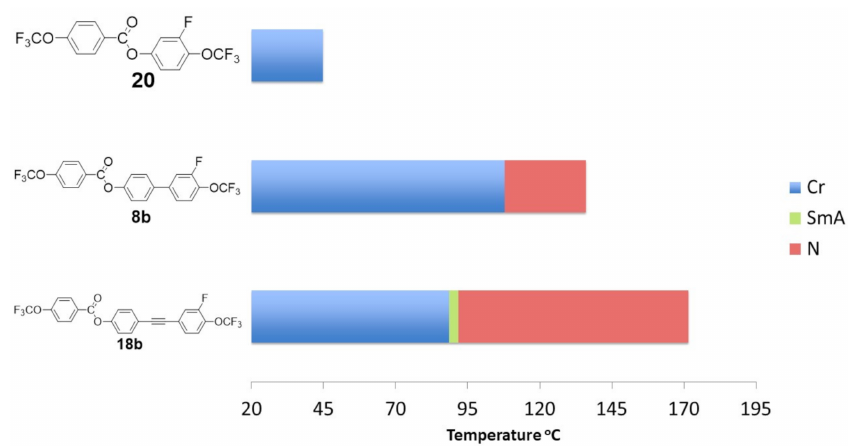
Figure 12. The influence of the core structure on the mesomorphic